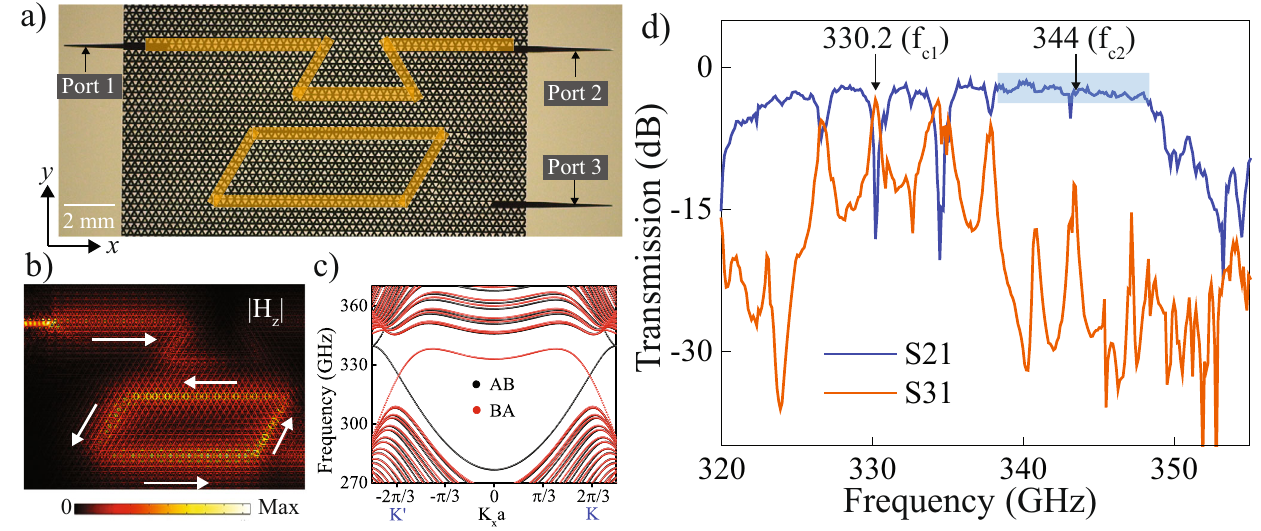
Fig. 3 | Coupled topological waveguide-cavity as an on-chip demultiplexer. a Optical image of the fabricated VPC cavity-waveguide chip. Orange lines indicate the domain walls corresponding to VPC waveguide and topological cavity, respectively. b The simulated magnetic fi eld intensity distribution of valley edge state at the cavity resonance frequency (330.2GHz). The white arrows indicate the Poynting vectors for the edge states. c Projected band diagram for the supercell representing both AB (black dot) and BA (red dot)